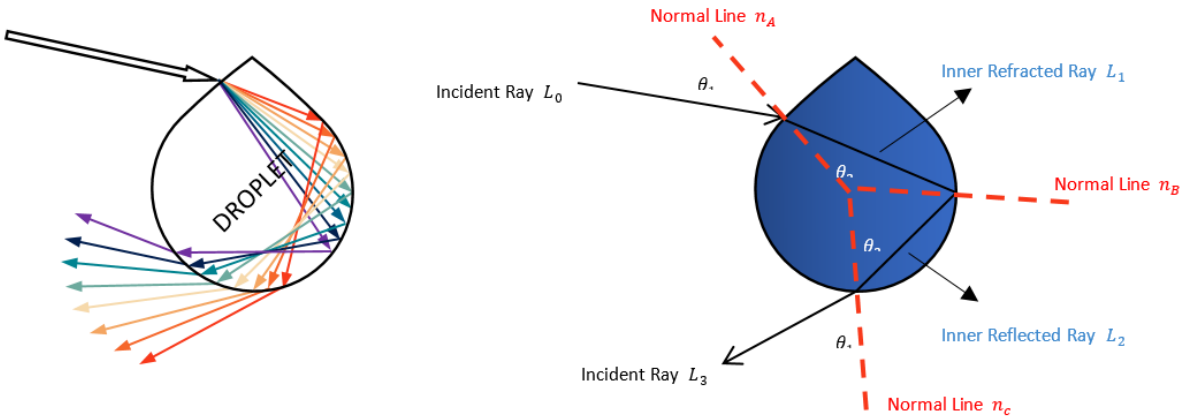
Figure 3. Light dispersion and colors of rainbow and vector form of refraction and reflection in rainbow. in